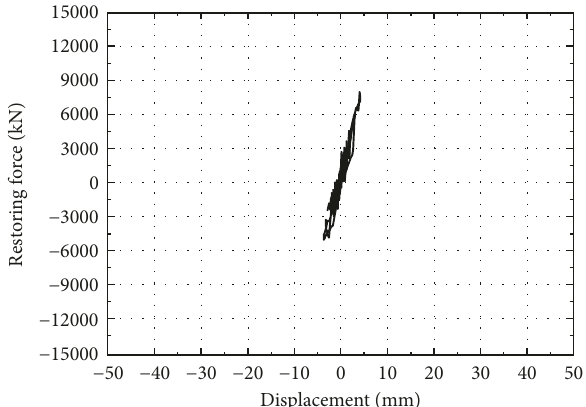
Figure 25: Hysteresis curve of intensity 7 frequently of Alaska (transverse